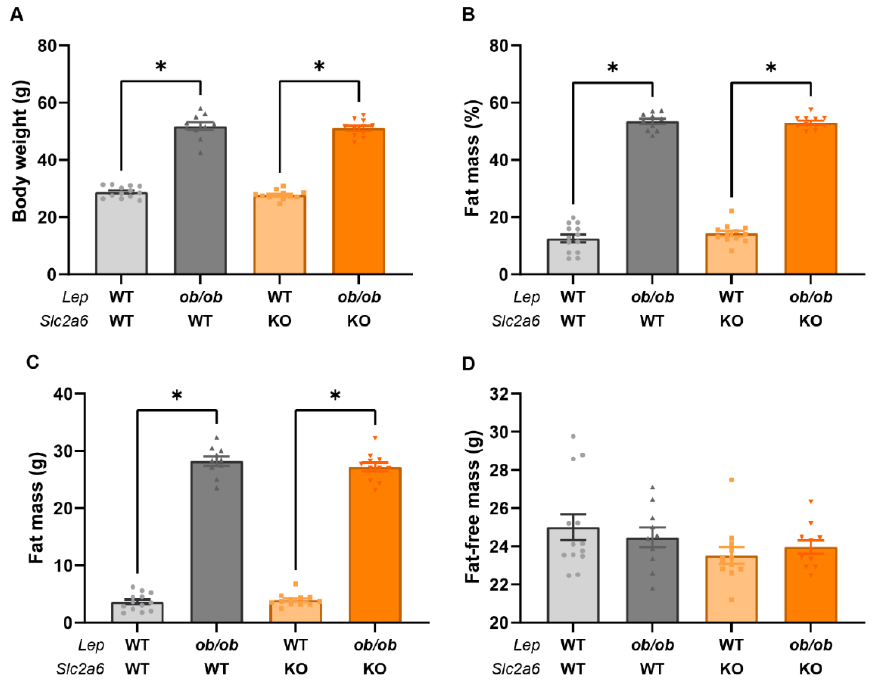
Figure 4. Body weight and composition were altered by leptin ( Lep ) but not by the Slc2a6 genotype at 16 weeks of age in male mice. Body weight ( A ), fat mass as percentage of total body mass ( B ),